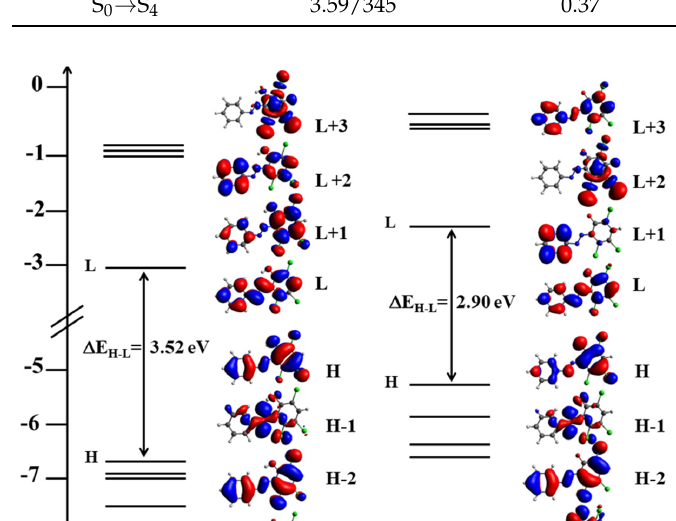
and hypsochromic effects if compared with the analogous transition detected for t -DZH :